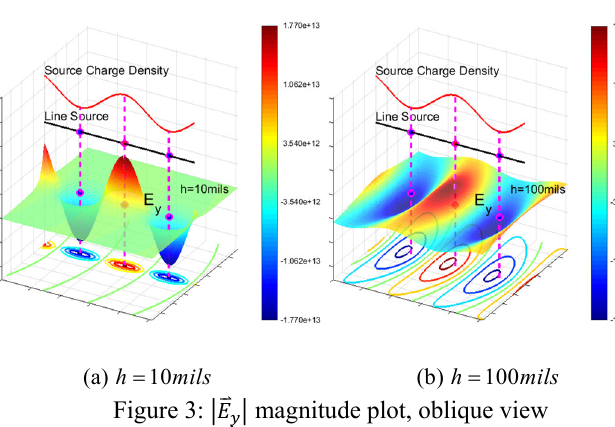
Figure 3: ⃑ magnitude plot, oblique view